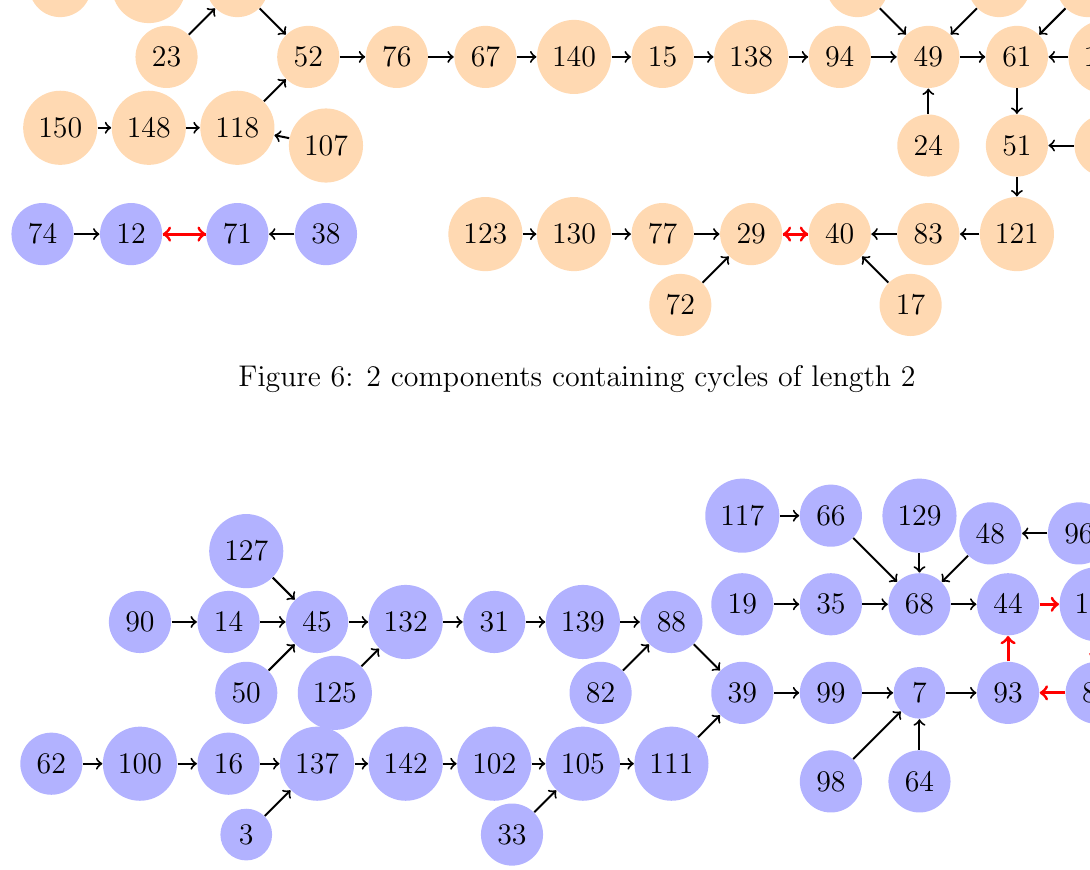
Figure 7: The unique component containing cycle of length